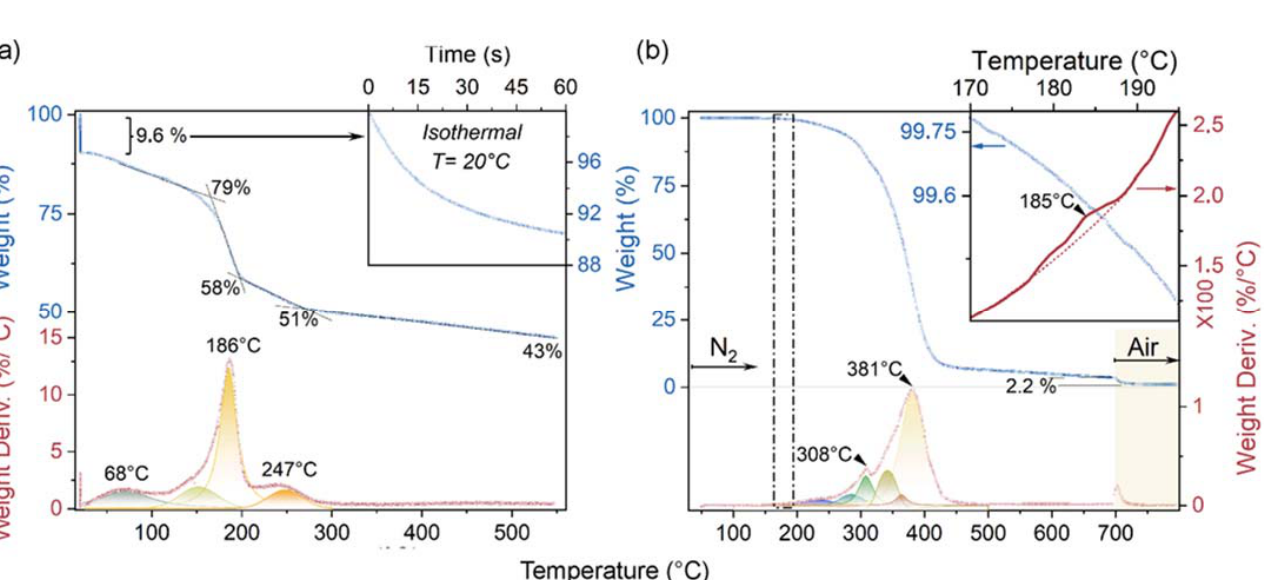
Figure 1. Multilayered leather: ( a ) SEM cross-sectional view; ( b ) representation of the layer structure and composition. In the inset of ( a ), a picture of flexible layered leather is shown. Finally, underneath the compact PVC layer, there was a PU underlayer of variable thickness for the good appearance and touching of synthetic leather. The structure and composition of the different layers had a soft texture; the material is flexible and soft to the touch, suitable for covering surfaces. This complex structure represents a good material for housing integrated electronics [30]. TGA/DTGA analyses of the GO and 2 wt.% GO-loaded PU layer are shown in Figure 2a and b, respectively.